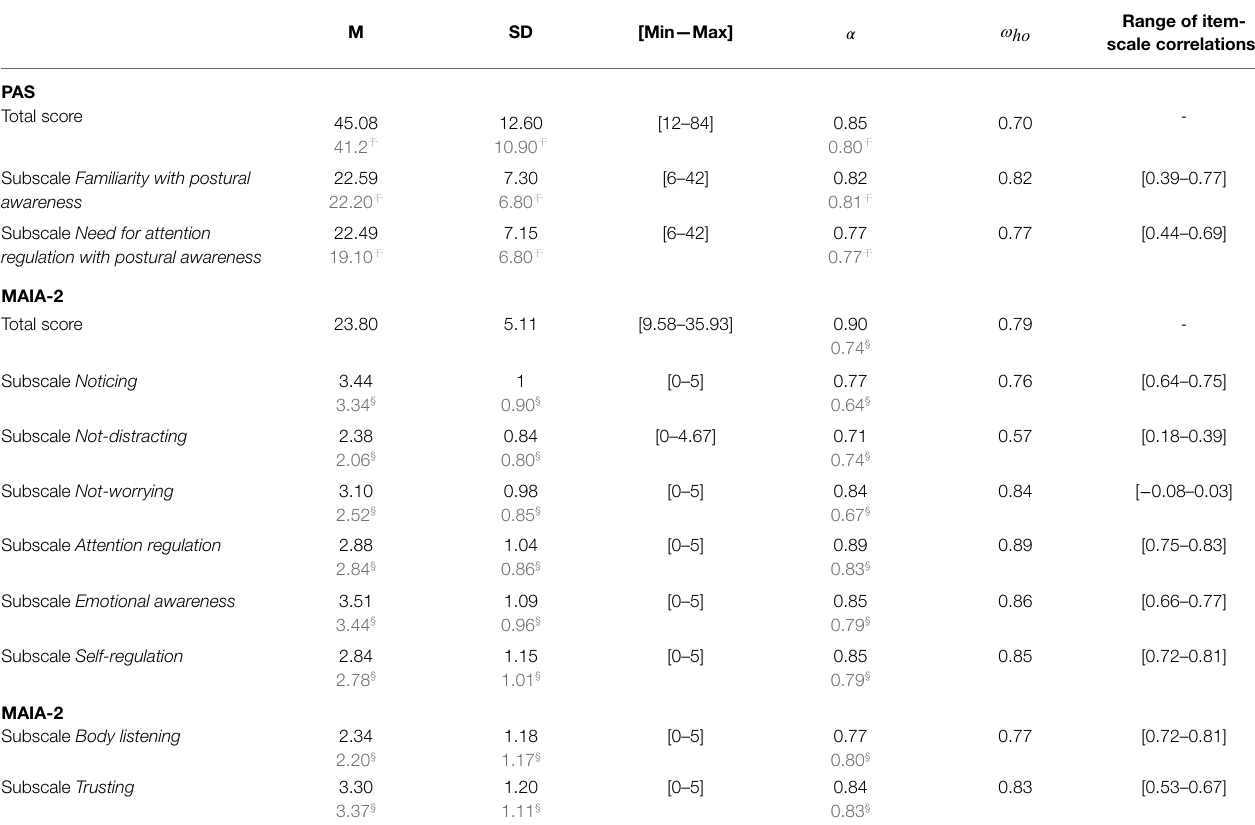
Range of item- scale correlations #